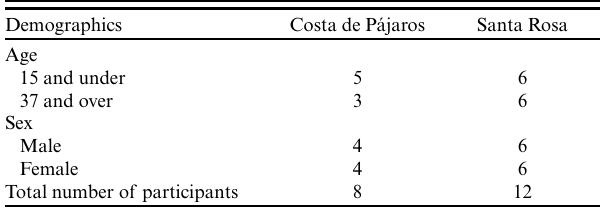
Table 1. Demographic characteristics of photovoice workshop participants.